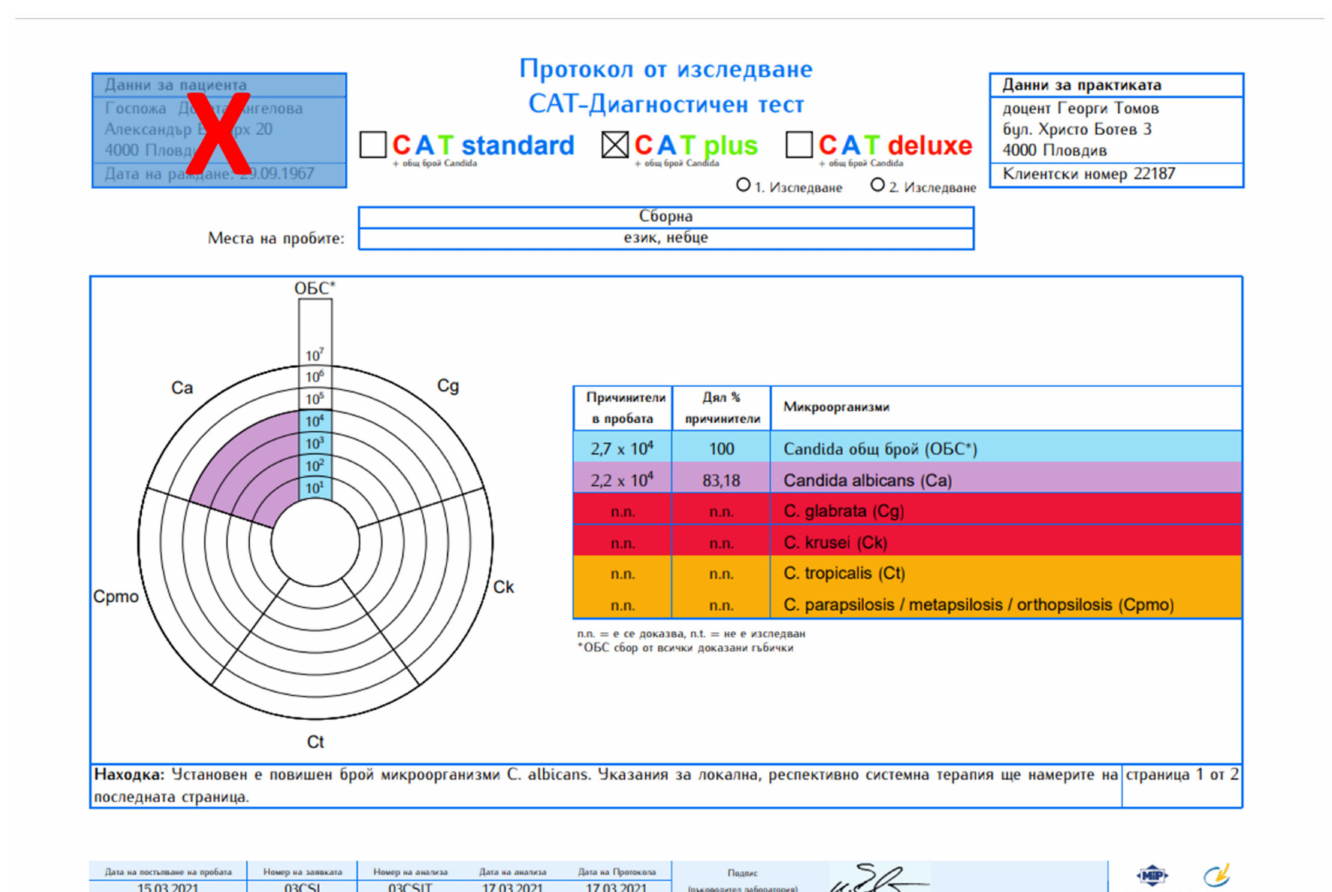
Figure 3. An anonymized result from CAT plus test revealing presence of C. albicans